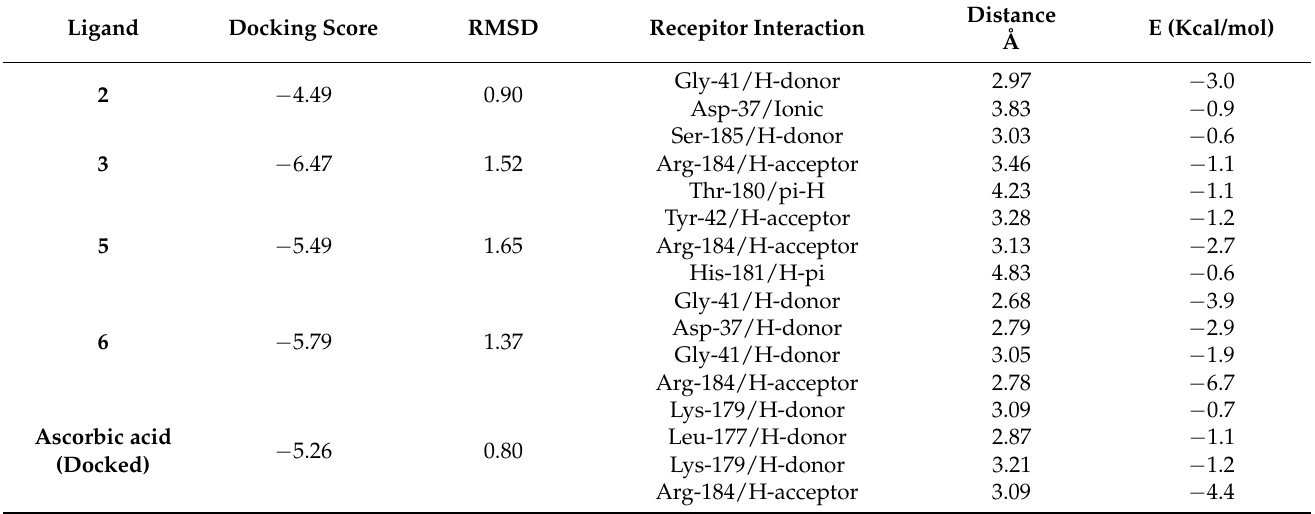
Table 3. The binding scores, RMSD values, receptor interactions, distances, and energies of our promising candidates ( 2 , 3 , 5 , and 6 ) were recorded compared to the docked ascorbic acid as a reference standard inside the binding pocket of cytochrome c